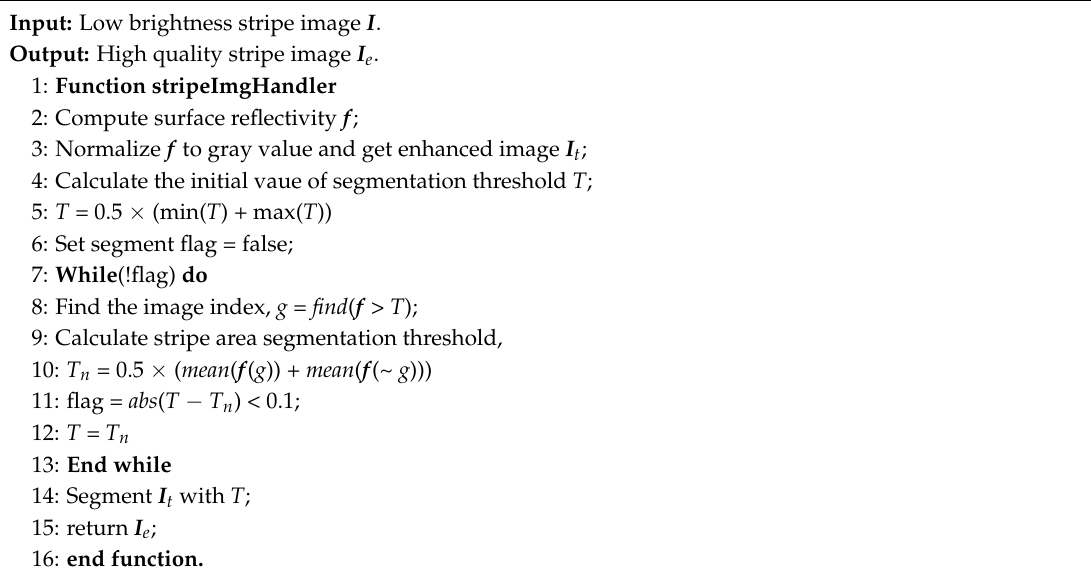
Algorithm 1. High Dynamic Stripe Image